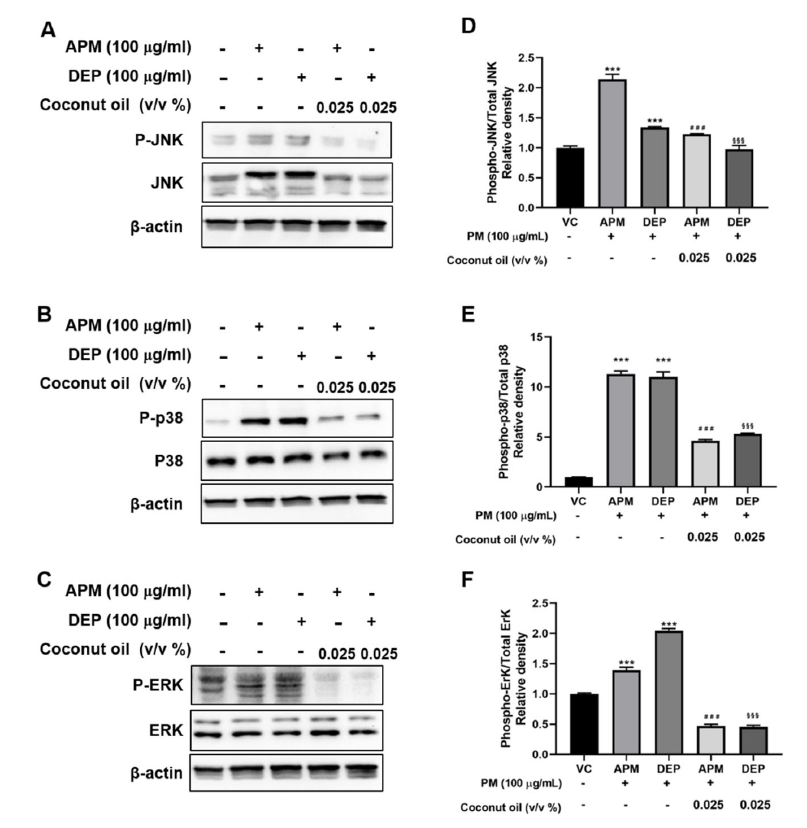
Figure 5. Effect of coconut oil on mitogen − activated protein kinase (MAPK) pathway in artificial particulate matter (APM) and diesel exhaust particles (DEP) − stimulated alveolar macrophages (MH − S). ( A – C ) Phosphorylation of extracellular receptor-activated kinase (ERK), C − Jun N − terminal kinase (JNK), and p38 MAPK was detected via Western blotting. ( D – F ) Relative densities of p − JNK, p − p38 MAPK, and p − ERK proteins. Vehicle control (VC) was treated with cell medium including 10% distilled water. Data are presented as the means ± SD (n = 3 per group). The normalized value of target protein expression level in the control group was set to 1. *** p < 0.001 vs. VC; ### p < 0.001 vs. APM; §§§ p < 0.001 vs. DEP groups.